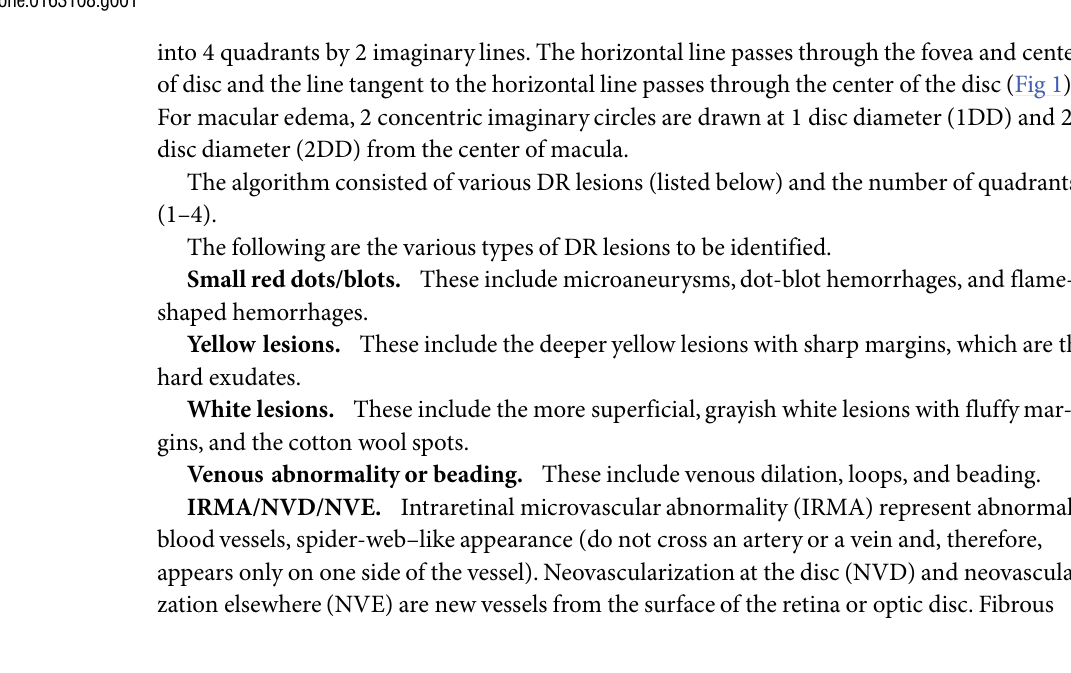
Fig 1. The red–green–yellow triage algorithm for quadrant-wise and macular evaluation, by using single-field 45 degree posterior pole photograph (lower left retinal